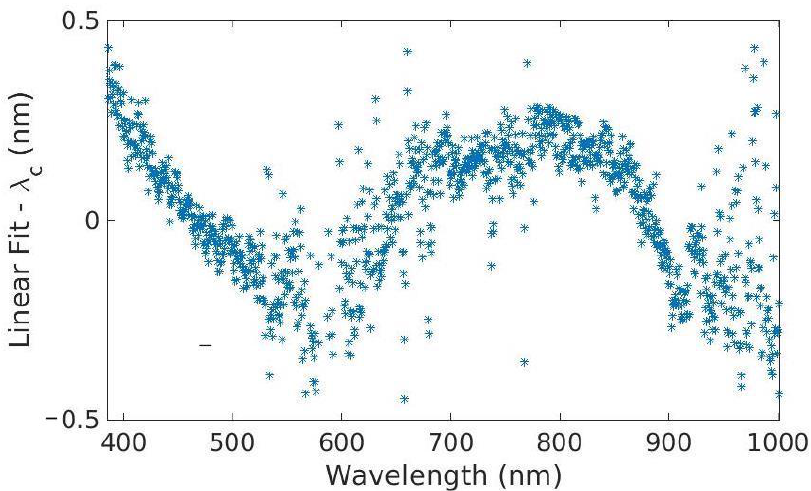
Figure 8. The residue of the center wavelength of SOLARIS spectral bands (pixels) from a linear mapping. The abscissa represents spectral bands denoted by their center